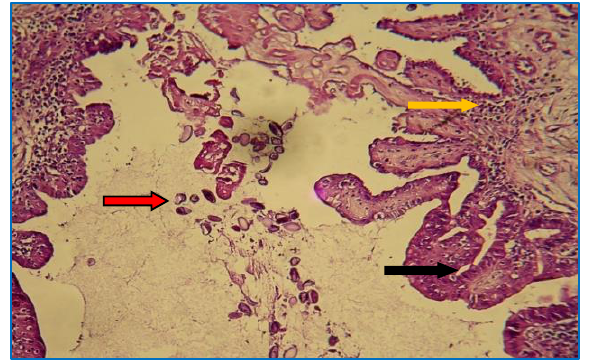
Figure, 11: G4: Liver of rabbit at 30 days post infection showing bile duct contain few oocysts in the lumen ( ) (H and E ) with moderate hyperplasia ( ) and mild infiltration of mononuclear cells in the lamina properia of mucosa ( ) (H and E 10x ).